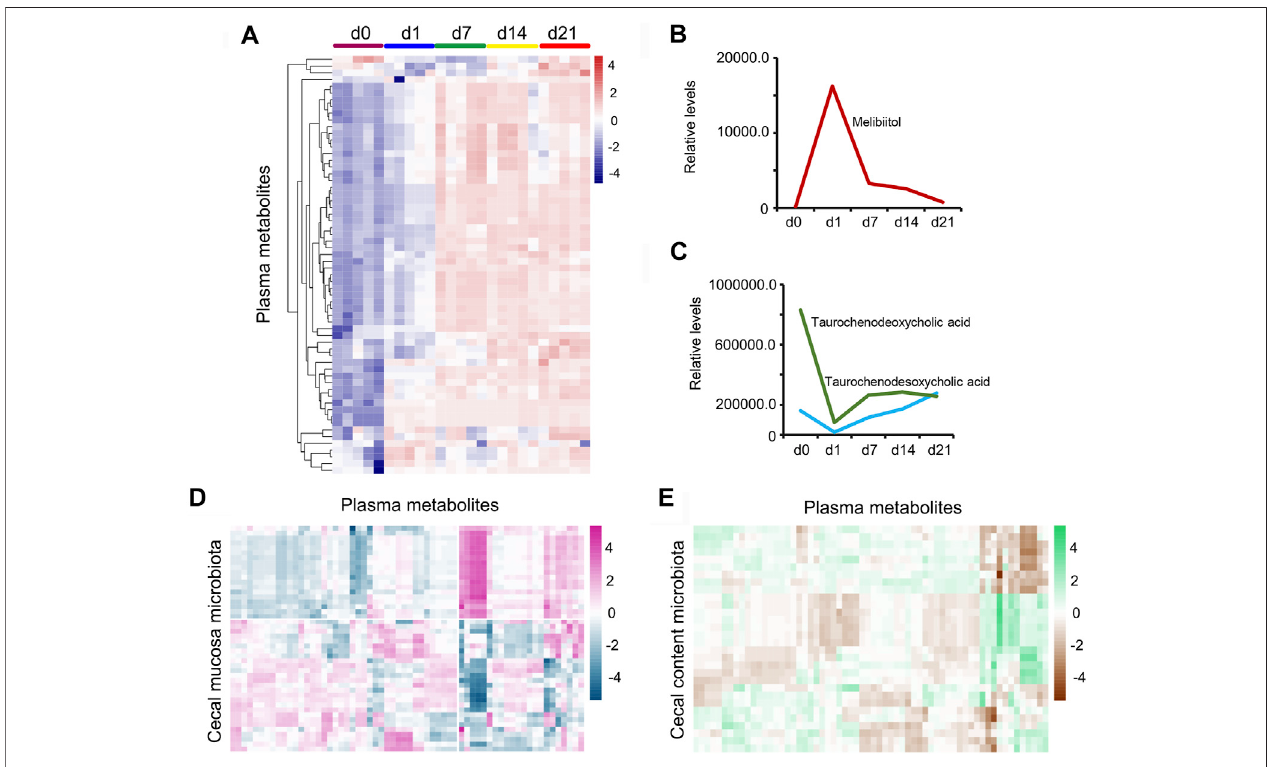
FIGURE 10 | Piglet plasma metabolism. (A) Heatmap for the continuing increase in the expression levels of 62 metabolites from d0 to d21. (B) Plasma concentration of Melibiitol at different time points. The X-axis shows the time points while the Y-axis presents the relative levels. (C) Plasma concentration of taurochenodeoxycholic acid and taurochenodesoxycholic acid at different time points. The X-axisshows the time points while the Y-axis presentsthe relativelevels. (D) Pearson correlation of the proportion of cecal mucosa microbiota and the concentration of plasma metabolites. (E) Pearson correlation of the proportion of cecal content microbiota and the concentration of plasma